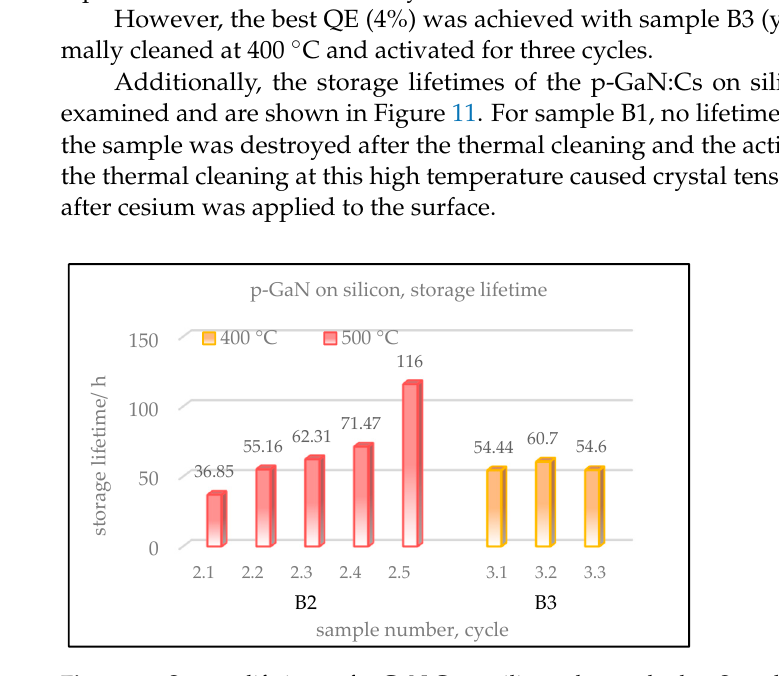
Figure 10. Gained QE values of p-GaN:Cs on silicon photocathodes, depending on various temperatures used in the thermal cleaning. Sample B1 (violet) was thermally cleaned above 600 °C and activated only once. Sample B3 (yellow), which was cleaned at 400 °C, achieved the best QE in three cycles. At the same time, sample B2 (red), which was thermally cleaned at 500 °C, showed relatively lower QE than B3, but a higher reproducibility in five cycles.